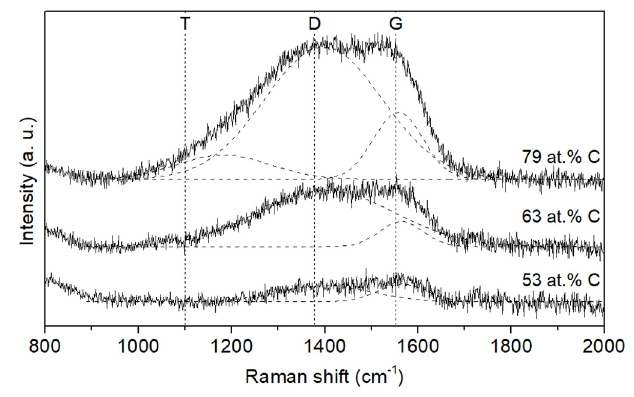
Figure 6. Raman spectra for tested coatings.